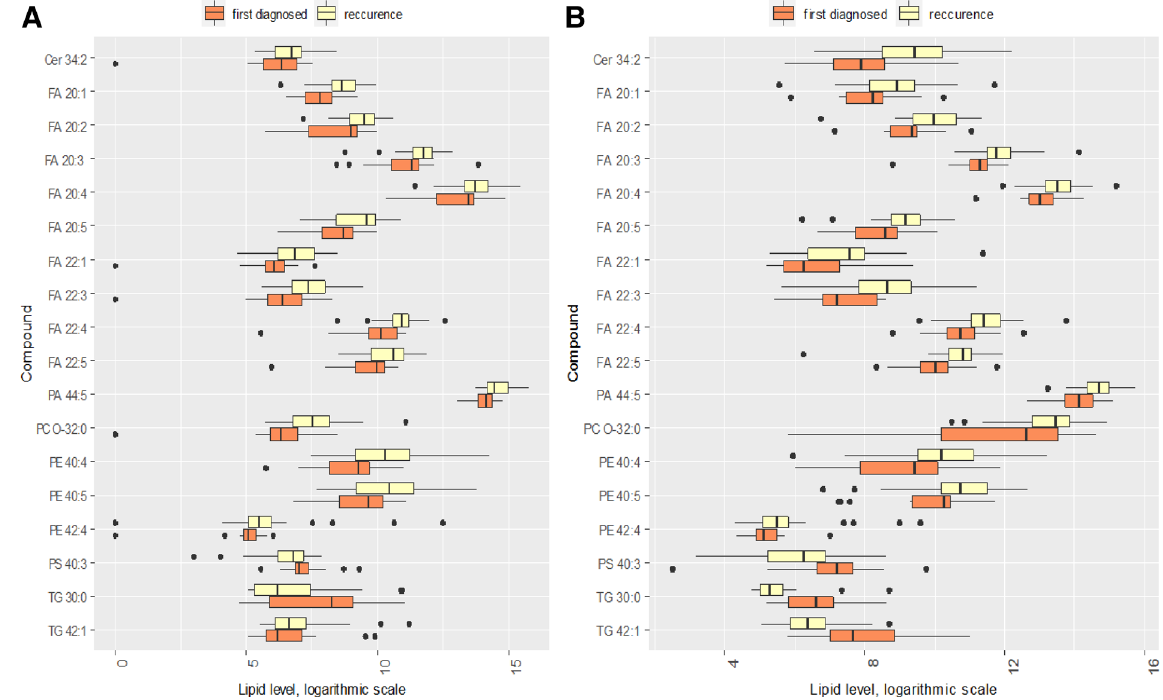
Figure 1. Relative intensity of marker lipids (p < 0.05) in the mass spectrum of ( A ) myometrium and ( B ) uterine fibroids. Orange color corresponds to the first-time diagnosed UF. Yellow color corresponds to RUF. The diagram shows Q1 − 1.5 × IQR, Q1, Me, Q3, Q3 + 1.5 × IQR. Black dots correspond to outliers. Cer ceramides, FA fatty acids, PC-O plasmalogens, PA phosphotidyl acids, PE phosphotidylethanolamines, PS phosphotidylserines, TG triacylglycerides.